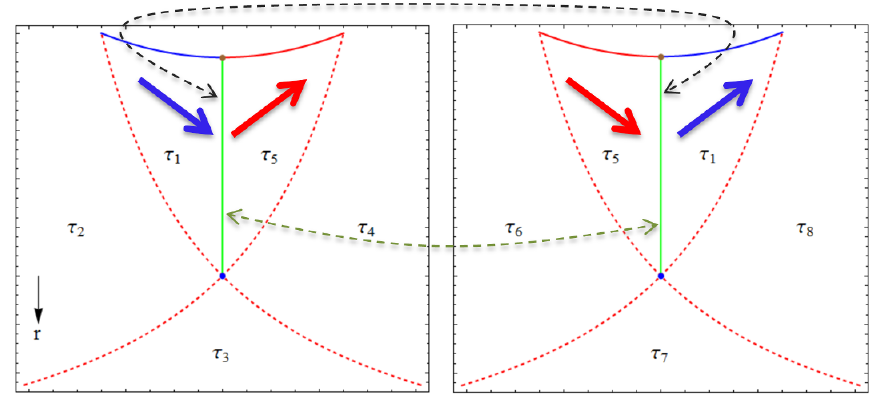
Figure 7 . This (cid:12)gure is taken from [1] and shows the replica story for a cyclically glued modular plane P n ( v 0 ) with n = 2. In the (cid:12)rst copy the boundary modular (cid:13)ow line L v parametrized by (cid:28) 1 0 (blue line) passes through A ( v 0 ) and get into the next copy. The bulk (cid:13)ow (blue arrow) should also 0 go through R A ( v 0 ) (the green line) to the next copy then go back to L v . A similar story happens 0 to the (cid:13)ow lines parametrized by (cid:28) 5 (the red line and arrow). The dashed arrows shows the cyclic gluing on R A ( v 0 ) 1 ; 2